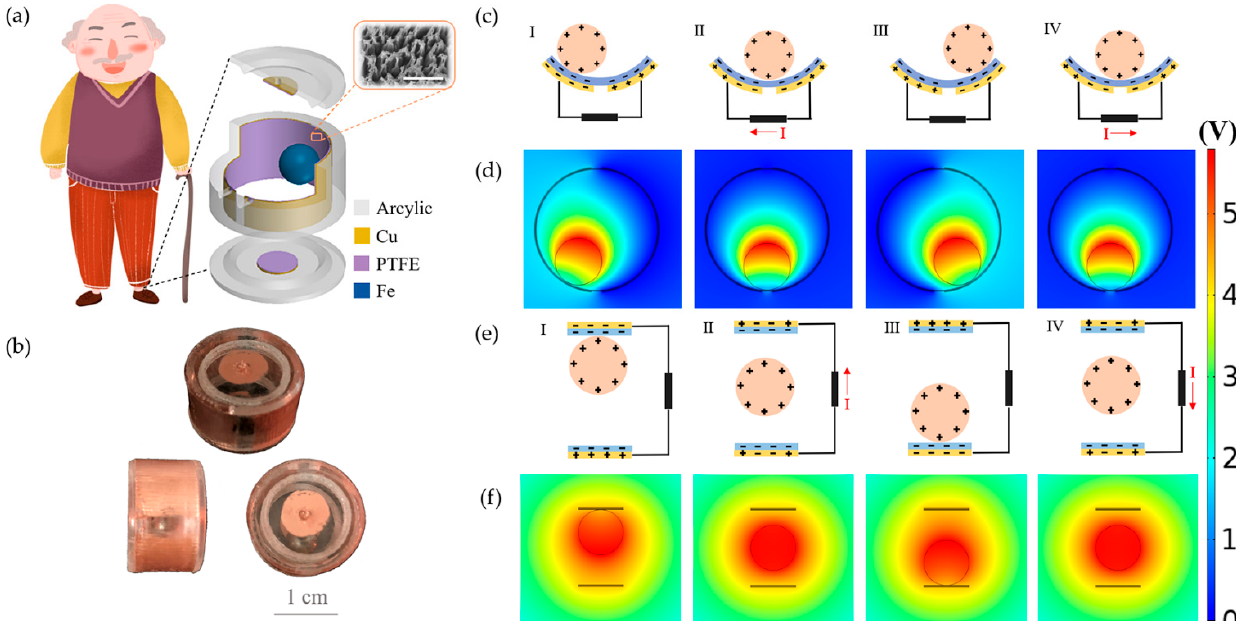
Figure 1. Overview of the SWS for healthcare monitoring. ( a ) The SWS was attached to the shoe to serve as healthcare monitoring. The illustration shows the SEM image of the PTFE film. The scale bar is 1 μ m. ( b ) Physical pictures of the SWS. The scale bar is 1 cm. ( c ) Working mechanism of the SC. ( d ) The voltage distribution between the Fe ball and PTFE film with Fe ball moving along the circumference. ( e ) Schematic diagrams of the TBC. ( f ) The voltage distribution between the Fe ball and the PTFE film with the Fe ball jumping up and down.